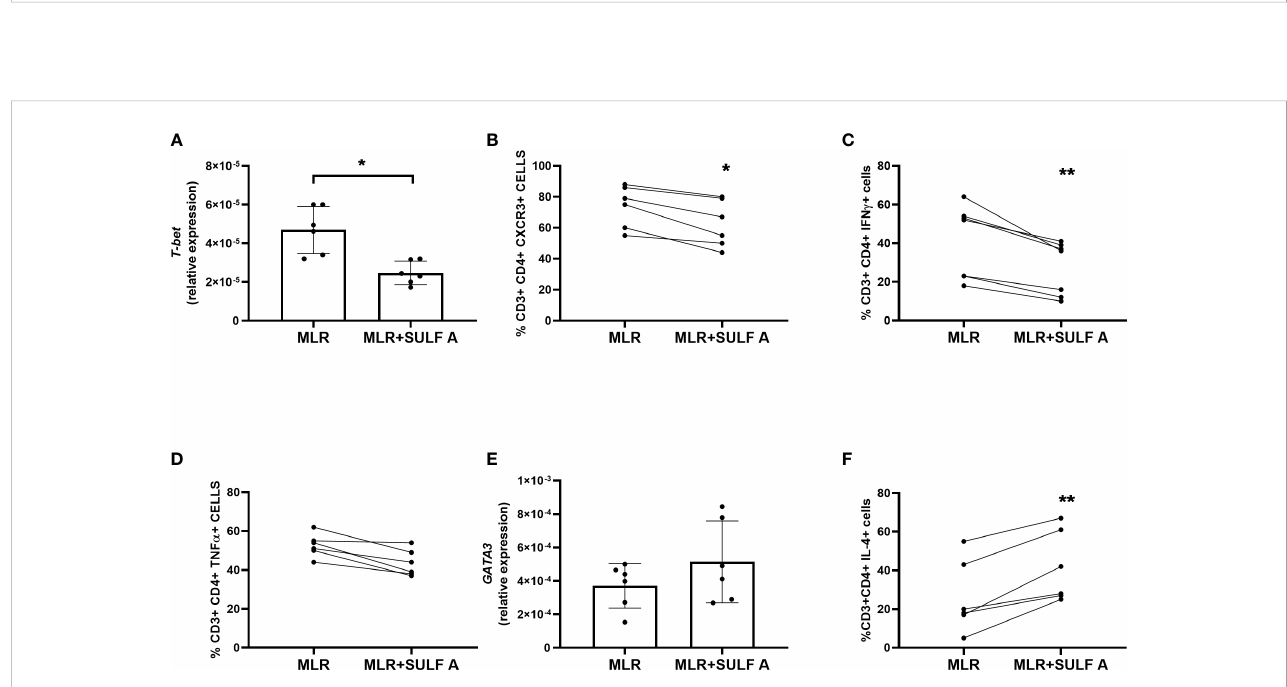
FIGURE 3 Effect of SULF A on Th1 and Th2 markers in the allogeneic MLR experiment. (A) RNA Expression of the transcription factor T-bet measured by qPCR after 7 day from the addition of SULF A to the co-cultures; (B – D) Surface expression of CXCR3, intracellular levels of IFN g and TNF a measured by FACS; (E) RNA expression of the transcription factor GATA-3 measured by qPCR; (F) Intracellular level of IL-4 measured by FACS. All qPCR results (mean ± s.d) were normalized to 18S mRNA and analyzed by D Ct method. Flow cytometry was performed on live CD3+/CD4+ cells (5000 events acquired) according to the gating strategy reported in Supplementary Figure 4. The intracellular cytokines were detected after a treatment of 6 hours with PMA, ionomycin and BFA. MLR = untreated co-cultures; MLR+SULF A = co-cultures treated with 10 m g / mL SULF (A) Statistical analysis (n = 6) was performed by paired non parametric Two-tailed T-test. * P < 0.05; ** P <